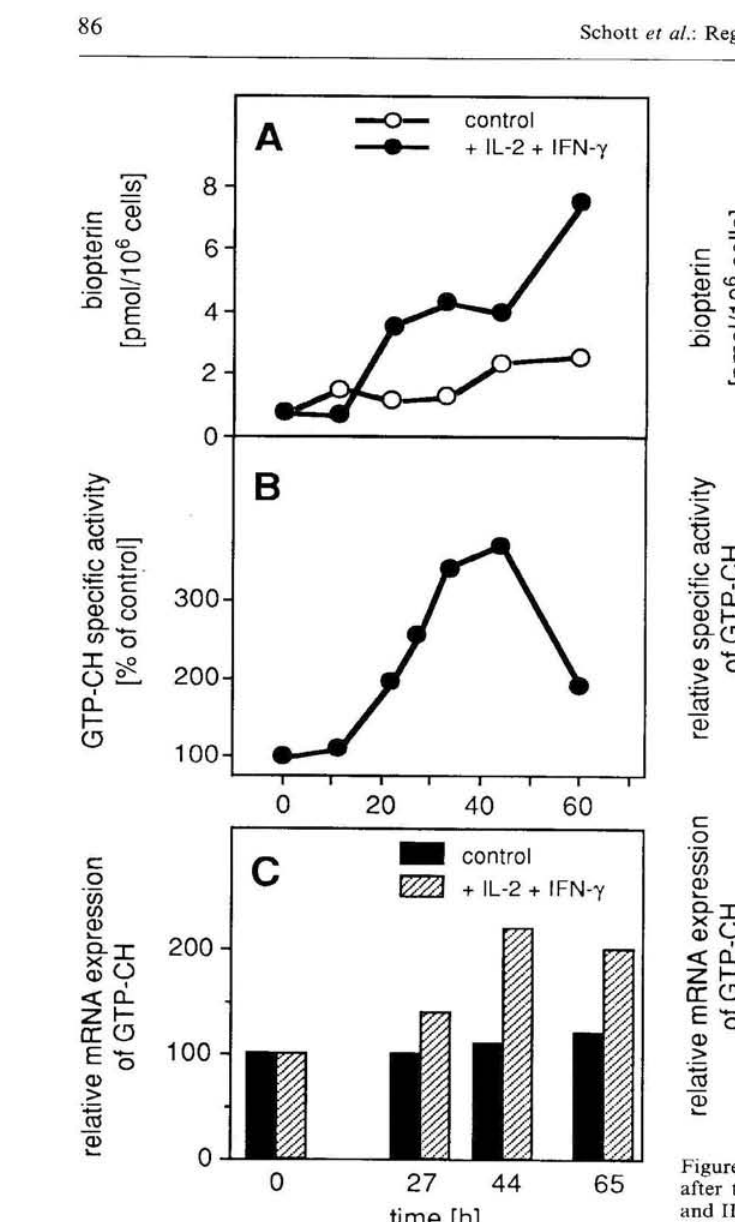
Figure 1. Time course of H 4 biopterin synthesis in MT-2 cells in controls and after induction with IFN-γ (500 U ml" 1 ) plus IL-2 (20 U ml" 1 ). A, H 4 biopterin concentrations; B, enzyme activity of GTP-cyclohydrolase I; C, relative mRNA expression.